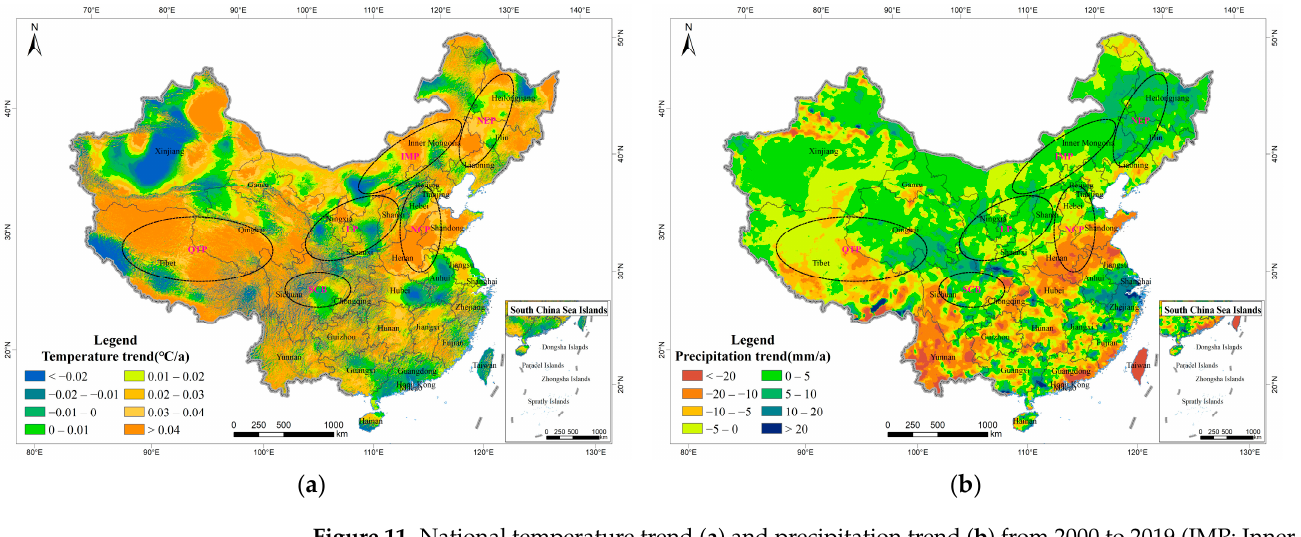
Figure 11. National temperature trend ( a ) and precipitation trend ( b ) from 2000 to 2019 (IMP: Inner Mongolia Plateau, NEP: Northeast Plain, QTP: Qinghai-Tibet Plateau, LP: Loess Plateau, NCP: North China Plain, SCB: Sichuan Basin).